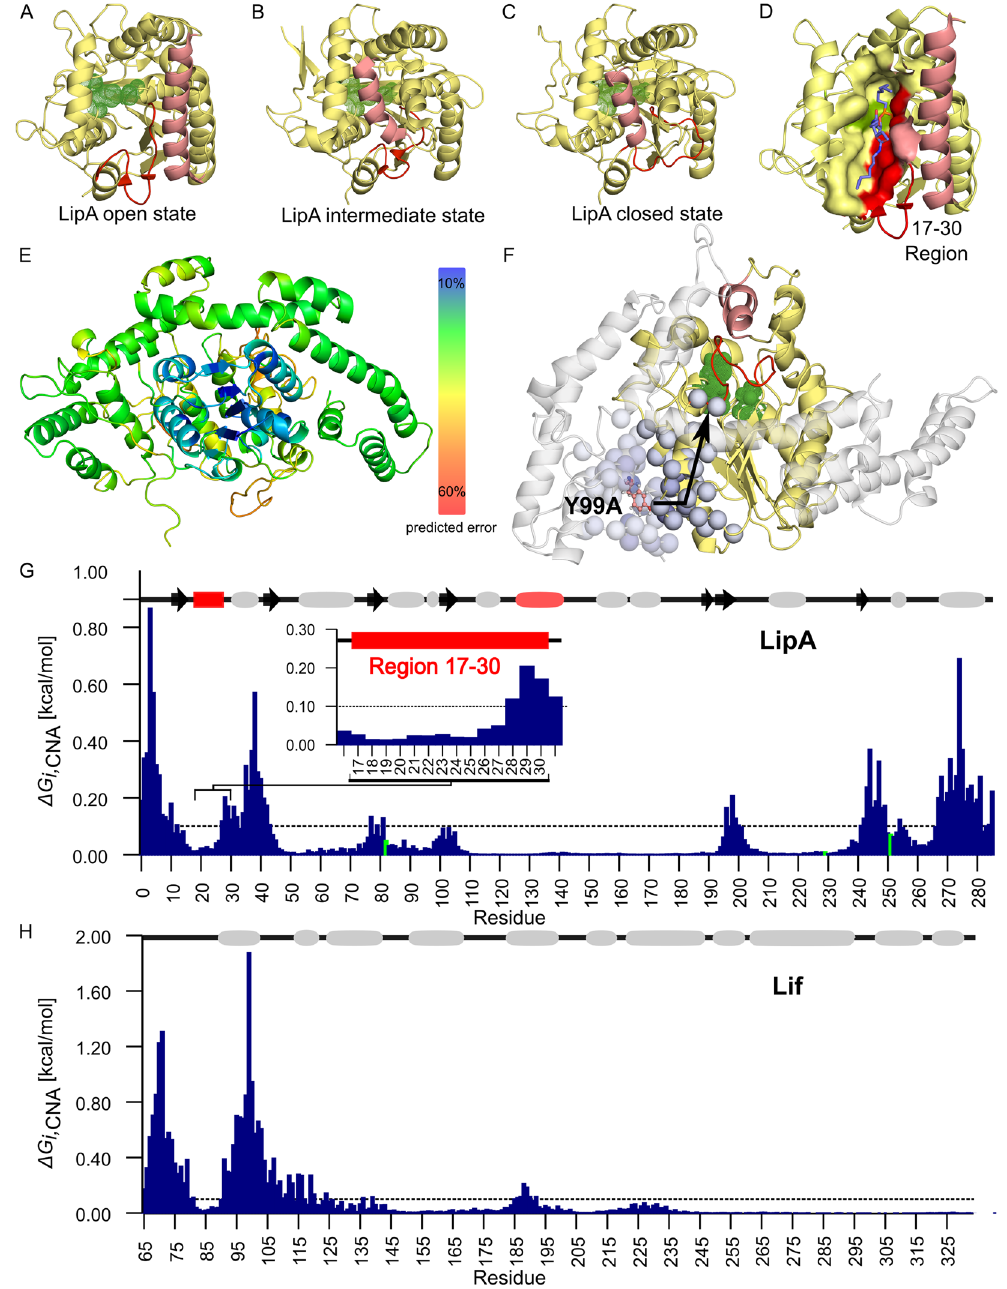
Figure 6. Influence of mutation Y99A in Lif on the structural stability of LipA. ( A ) Structure of P. aeruginosa LipA with OCP inhibitor bound in the active site crystallized in the open conformation (PDB code 1EX9 23 ), in which the helix α 5 (salmon) is moved away from the active site (catalytic triad residues S82, H251 and D229 shown in green). In this conformation, the active site is accessible for the substrate and LipA is enzymatically active. A short two-stranded β -sheet close to the active site is formed by residues 17–30 (red). ( B ) B. glumae lipase from the crystal structure of the Lif:LipA complex (PDB code 2ES4 10 ). The lipase shows a two-stranded β -sheet (red), a characteristic feature of the open (active) conformation, nevertheless helix α 5 (salmon) adopts a closed (inactive) conformation. This suggests a foldase-induced formation of a two-stranded β -sheet during activation of the lipase. ( C ) Crystal structure of B. glumae lipase crystallized in the closed conformation (PDB code 1QGE 50 ) with helix α 5 (salmon) covering the active site (residues as in panel A). In this conformation, a two-stranded β -sheet close to the active site is not formed. Residues 17–30 of B. glumae lipase, forming a two- stranded β -sheet, are indicated red. ( D ) Crystal structure of active P. aeruginosa LipA with inhibitor OCP bound in the active site (PDB code 1EX9). Region of residues 17–30 forms part of the active site (red), required for the binding of the ligand. ( E ) Homology model of the P. aeruginosa s Lif:LipA complex based on the structure of the B. glumae foldase-lipase complex (PDB code 2ES4 10 ) used as a template. The coloring indicates the model quality assessment by TopScore 24,25 , with bluish colors representing less than 10% structural error. ( F ) CNA